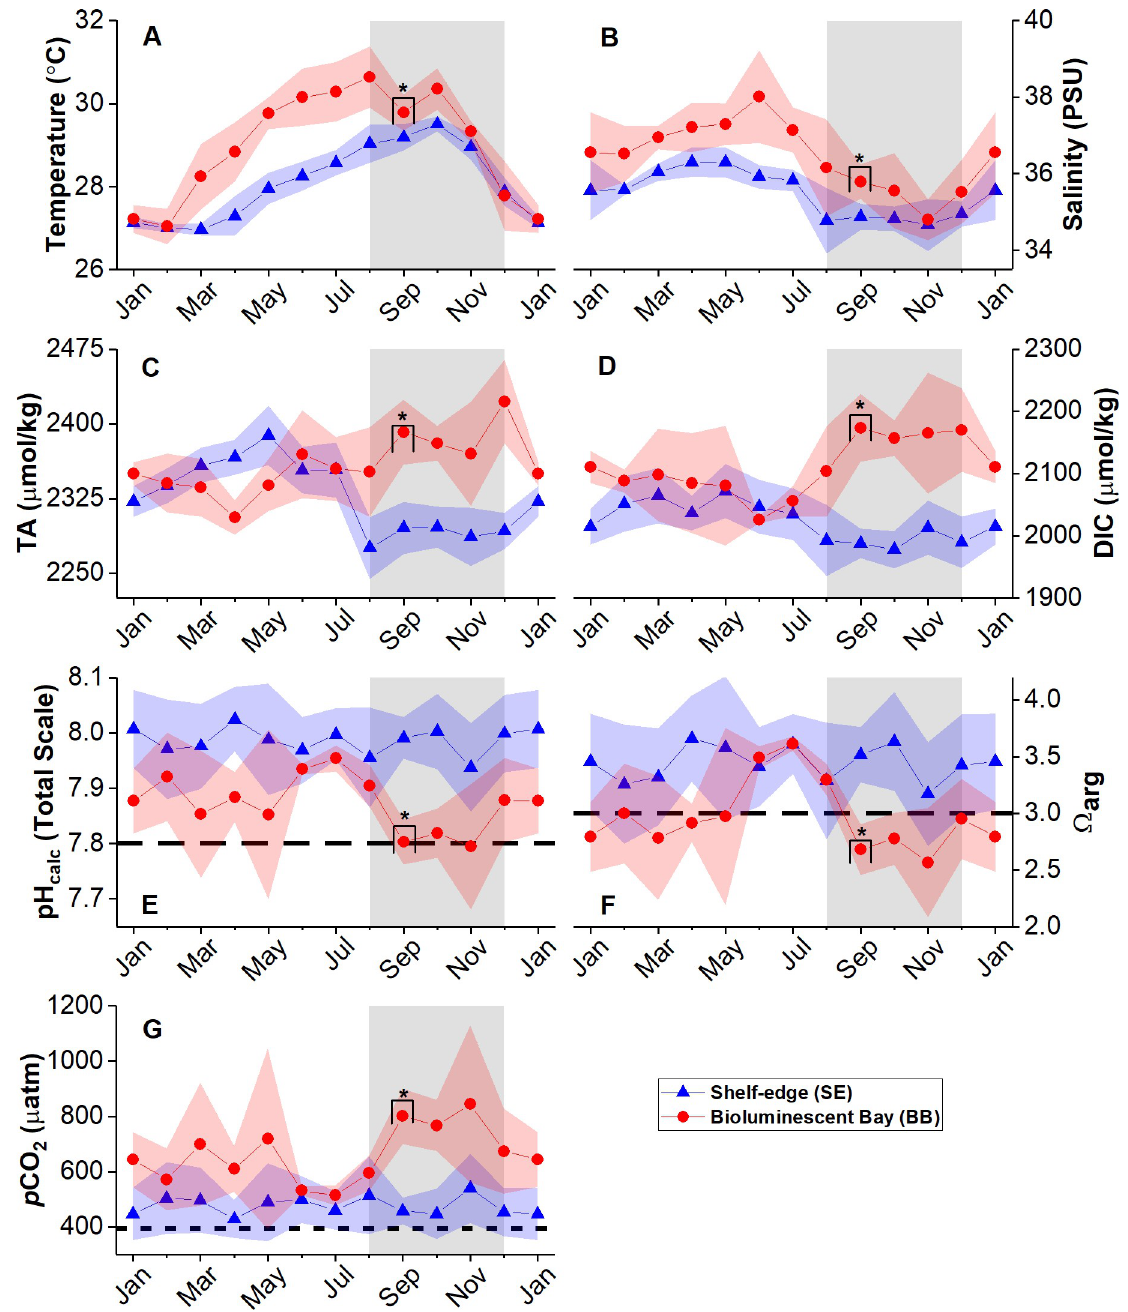
Fig 4. Monthly mean carbonate chemistry parameters at BB and SE stations. (A) Monthly mean temperature, (B) salinity, (C) TA, (D) DIC, (E) pH calc , (F) Ω arg and (G) p CO 2 . The long-dashed lines in (E) and (F) represent expected mean values by 2100 under business-as- usual scenarios (RCP 8.5) [55]. The short-dashed line in (G) is the mean atmospheric p CO 2 value (394 μ atm) during the sampling period. Red and blue shaded areas represent one standard deviation for each data point, while gray shades represent the wet season. For every averaged data point, n � 3. Data points depicted with an asterisk show where n = 3. Data are in S1 and S2